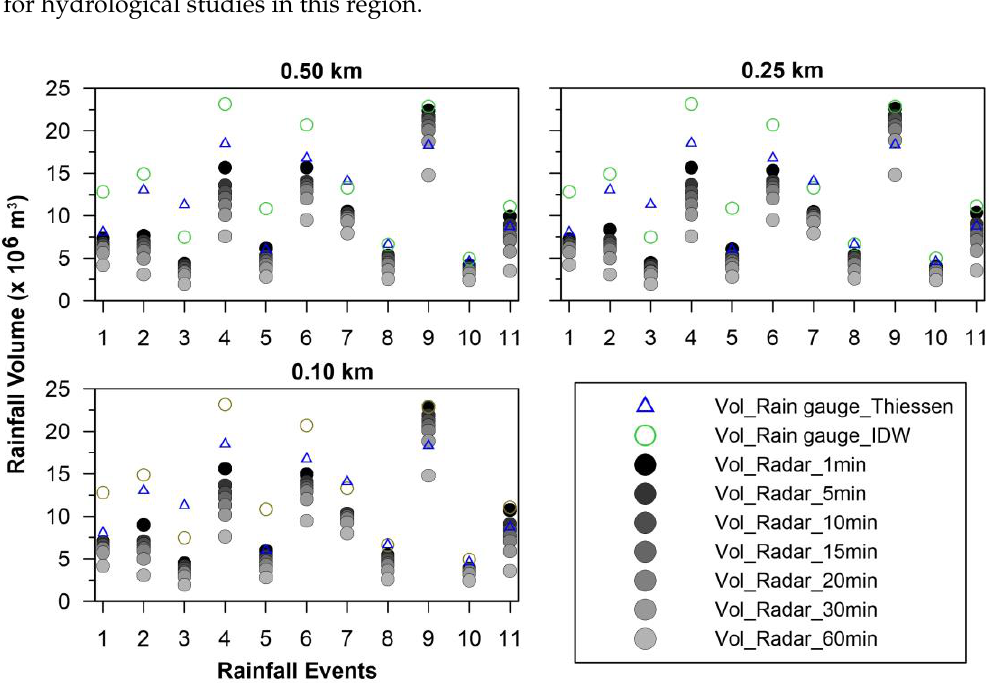
Figure 11. Relation of water volume and its percentage of coverage over the study basin area.